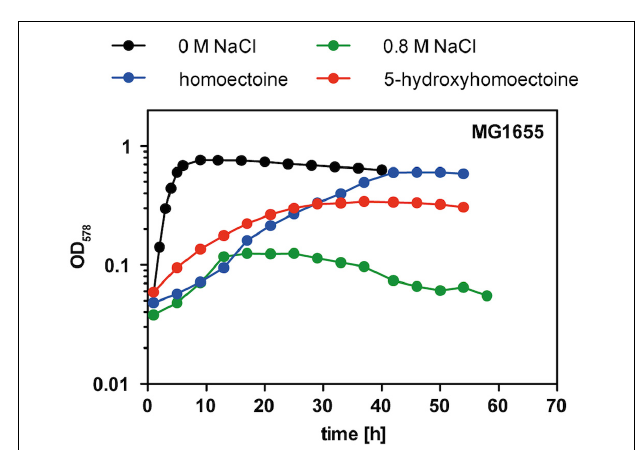
FIGURE 7 | Osmostress protection assay with 5-hydroxyectoine and 5-hydroxyhomoectoine. Growth of E. coli MG1655 ( proU + proP + ) in MMA without NaCl and in MMA containing 0.8 M NaCl without and with the addition of 1 mM of the indicated compatible solutes was monitored for 60 h. The OD 578 of the cultures was measured hourly in a plate reader (Epoch2, BioTek). The osmostress protection growth assay was conducted with two independently grown cultures. A representative set of growth curves is